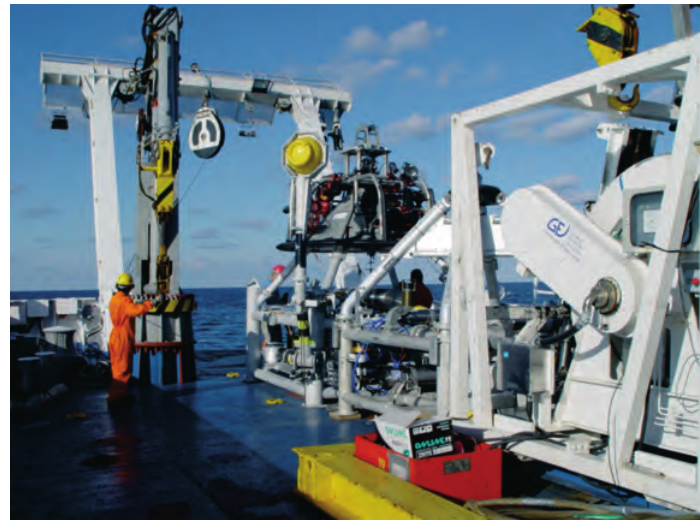
Fig. 1. MODUS and GEOSTAR-stations onboard R/V